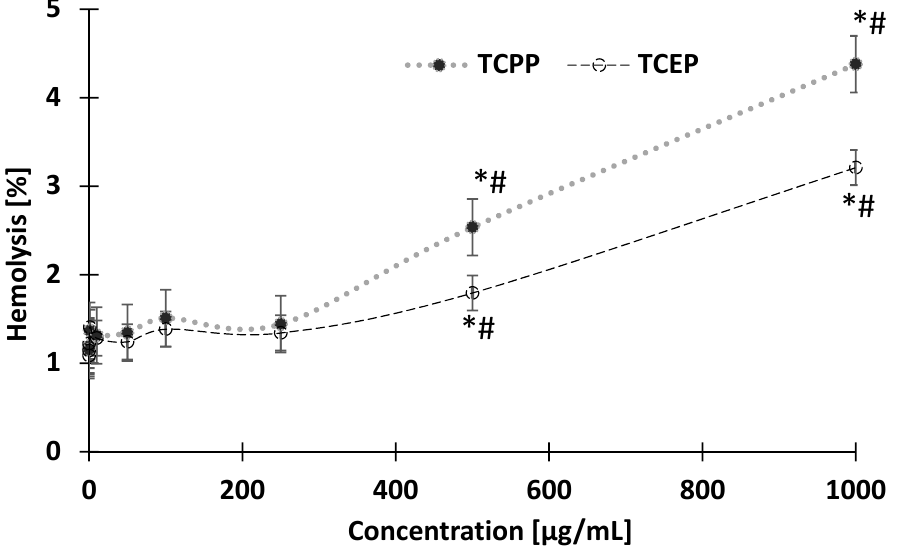
Figure 2. Hemolysis level in control erythrocytes and erythrocytes incubated with TCEP and TCPP in the concentrations from 0.001 to 1000 µ g/mL for 24 h. * p < 0.05 indicates statistically significant difference from control; (#) statistically significant difference between TCPP and TCEP. One-way analysis of variance (ANOVA) and a posteriori Tukey